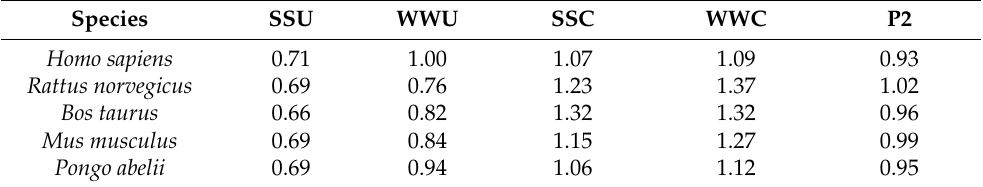
Table 5. The values of SSU, WWU, SSC, WWC, and P2 of the EPB41L3 gene in five species. Species SSU WWU SSC WWC Homo